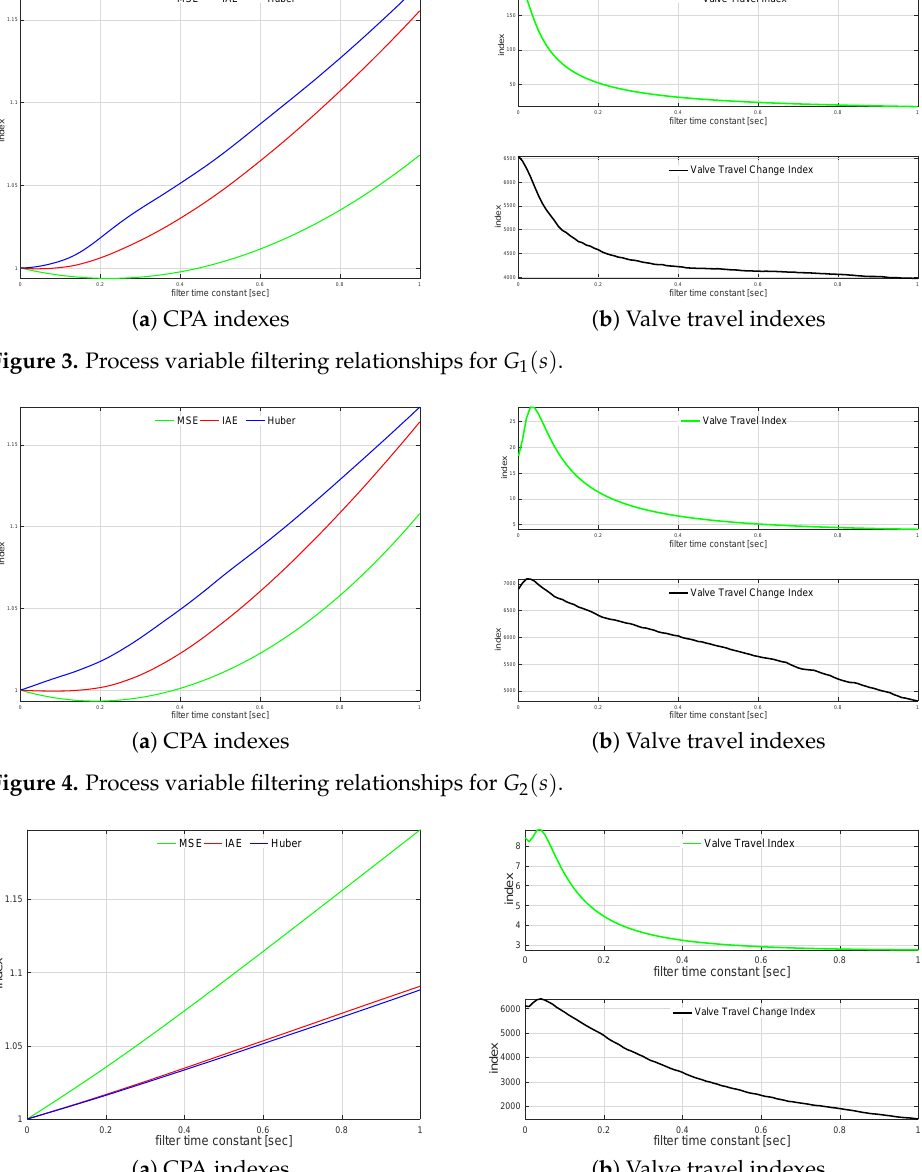
Figure 5. Process variable filtering relationships for G 3 ( s )